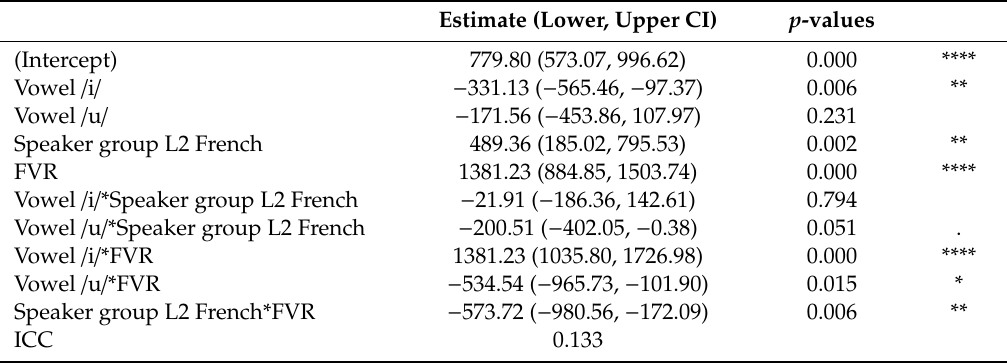
Table 4. Mixed-e ff ects linear regression model for COG at Timepoint 3. Estimate (Lower, Upper